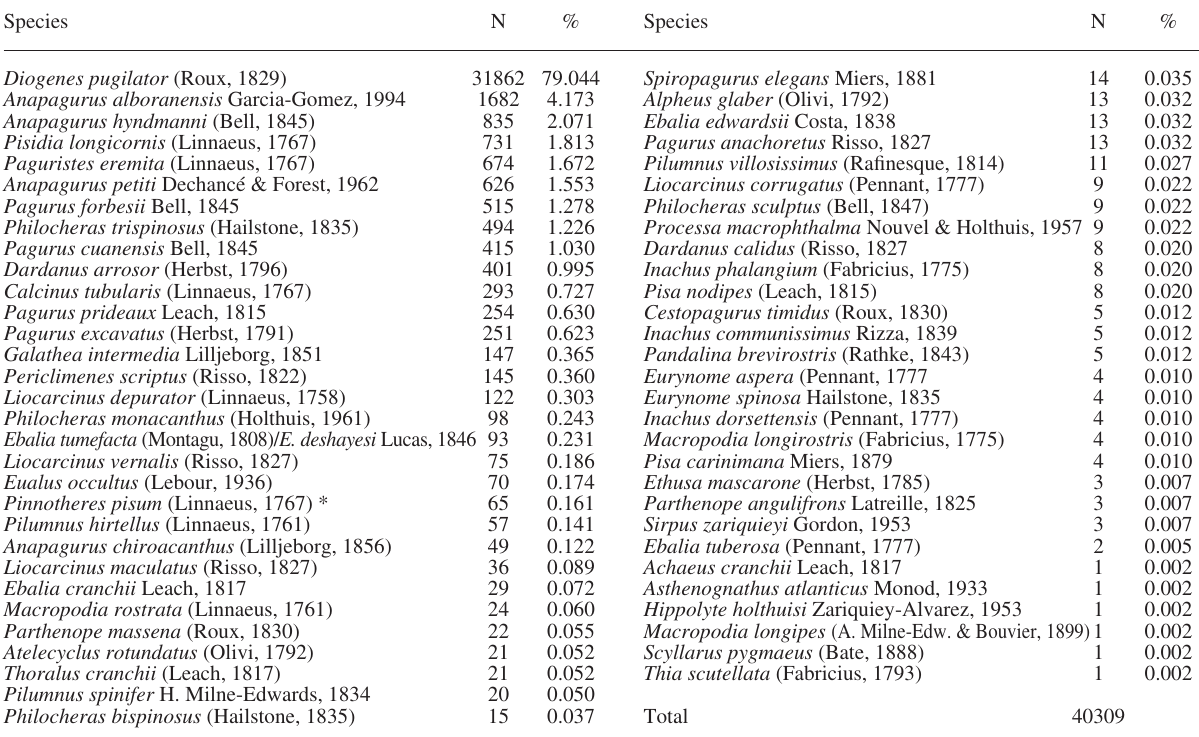
Table 4. – Total number of specimens (N) per species.